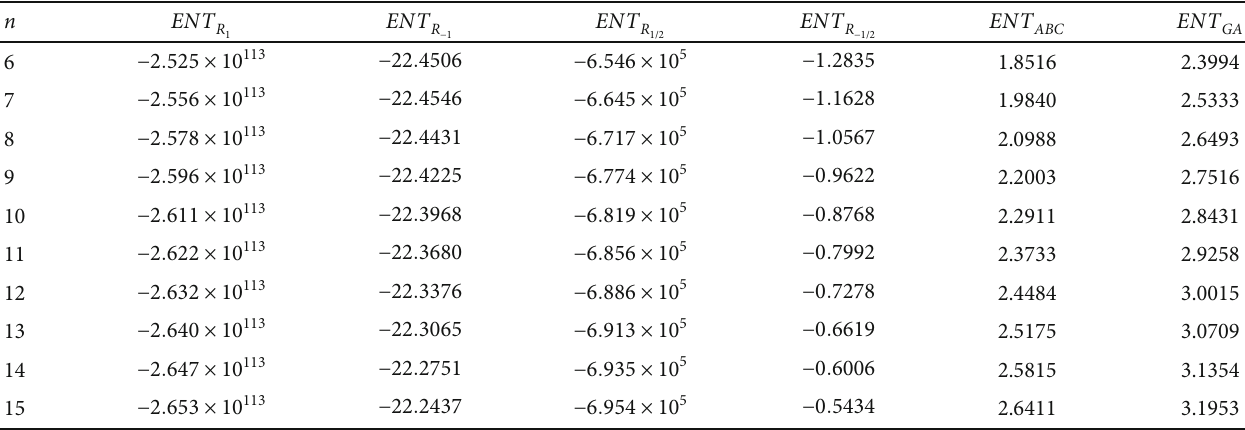
Table 4: Comparison table of entropies for POH ð n Þ :